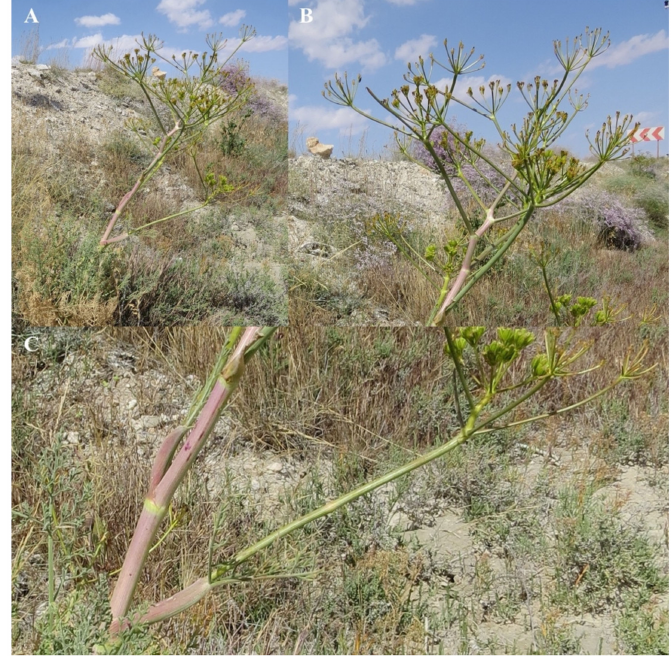
Figure 1. ( A , B ) General view of Ferula turcica . ( C ) Sheath.